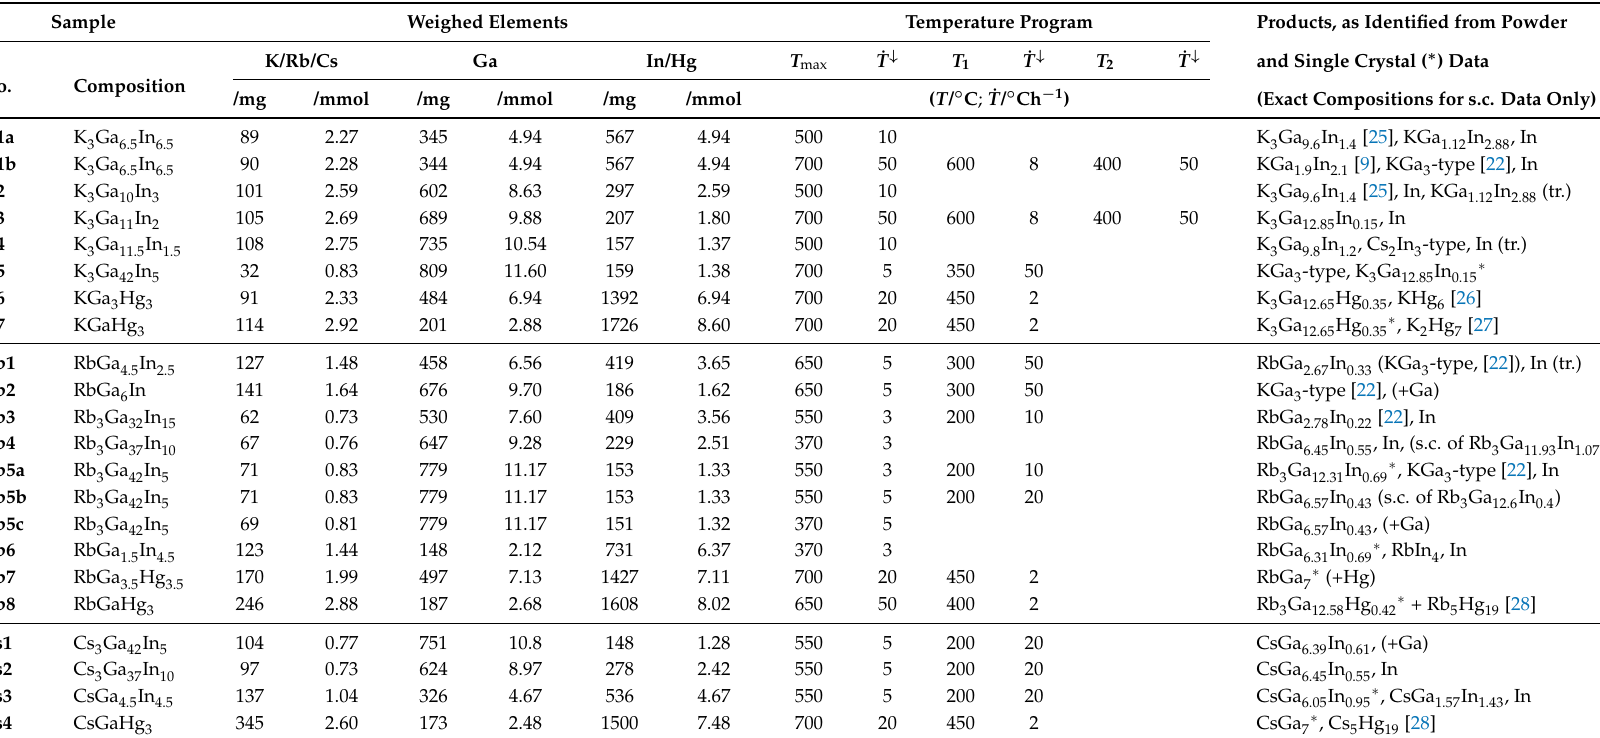
Table 1. Details of the synthesis of Ga-rich alkali gallides (tr: traces, s.c.: single crystals, ∗ full s.c. dataset; cf. Tables 2 and